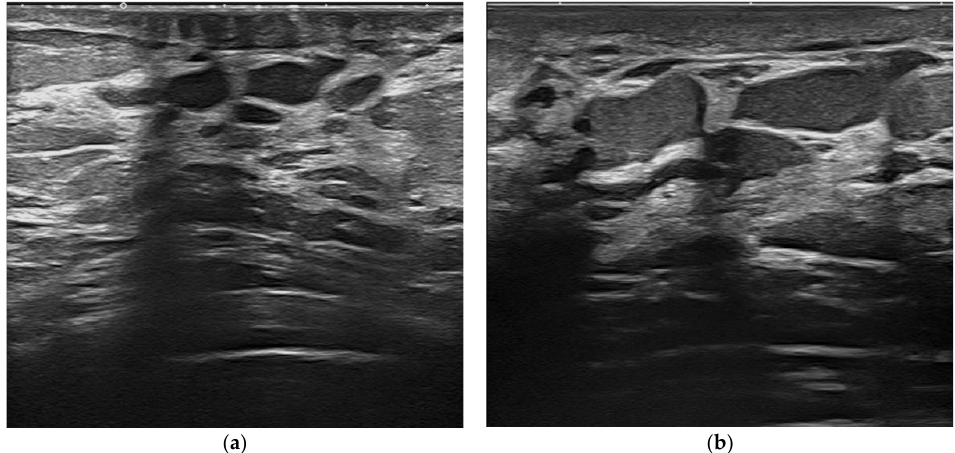
Figure 5. Ductectasia. Dilated ducts filled with dense, fluid material as they appear at 15 MHz ( a ) and at 22 MHz ( b ).